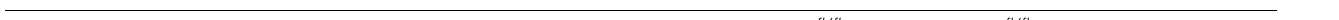
Fig. 1 Txnrd1 is required for thymic iNKT cell development. a – c T-cell populations in naive Txnrd1 fl / fl ; Cd4-Cre and Txnrd1 fl / fl littermate control mice were analyzed by fl ow cytometry. Representative FACS plots (left) and quanti fi cation (right) are shown. a Thymic T-cell development was assessed by gating